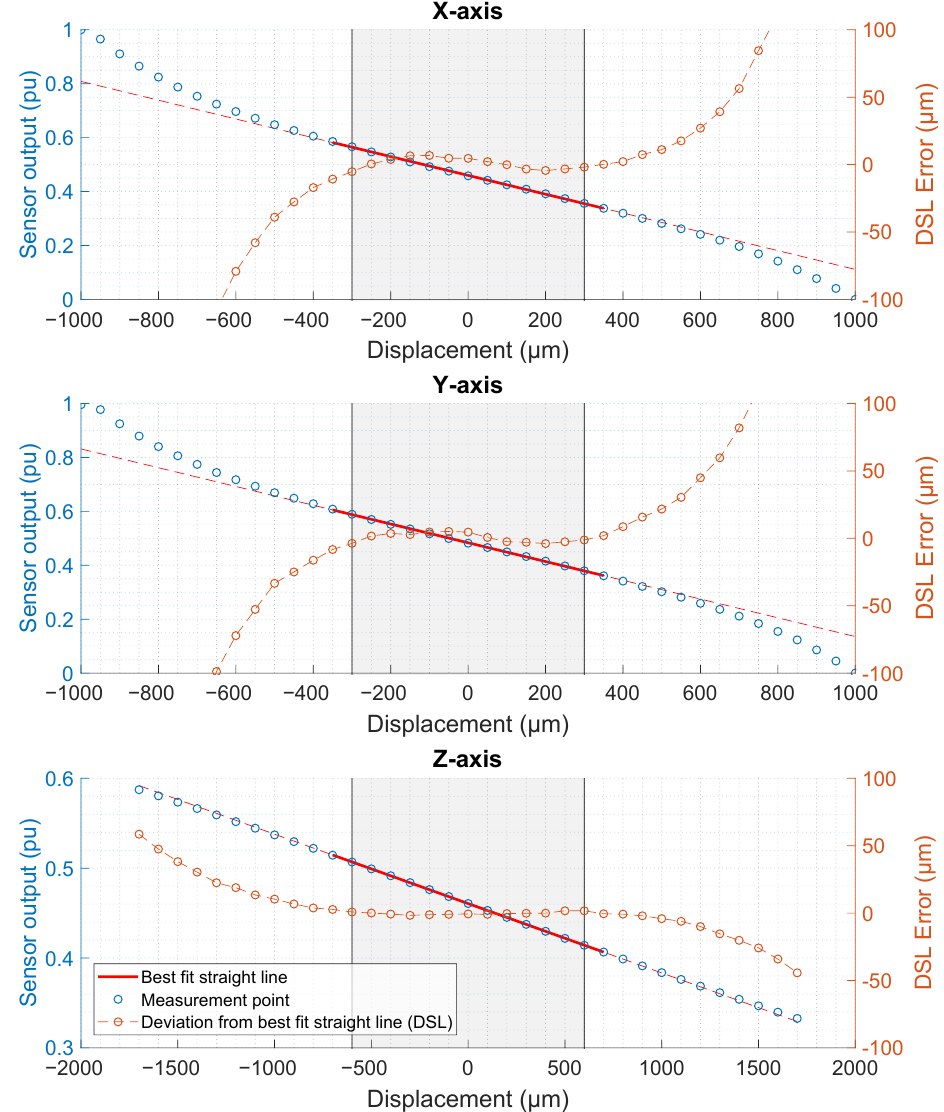
Figure 9. Static sensor linearity measurement on a manual three-axis linear stage. Measurement points (blue) and deviation points (orange) from the best straight-line fit (red). The grey area corresponds to the specified linear measurement range. The best straight-line fit corresponds to a radial gain of − 2870 µm/pu and axial gain of − 12,950 µm/pu. The maximum deviation from the best straight-line fit (DSL) throughout the linear measurement range is 7 µm for radial axes and 2 µm for the axial